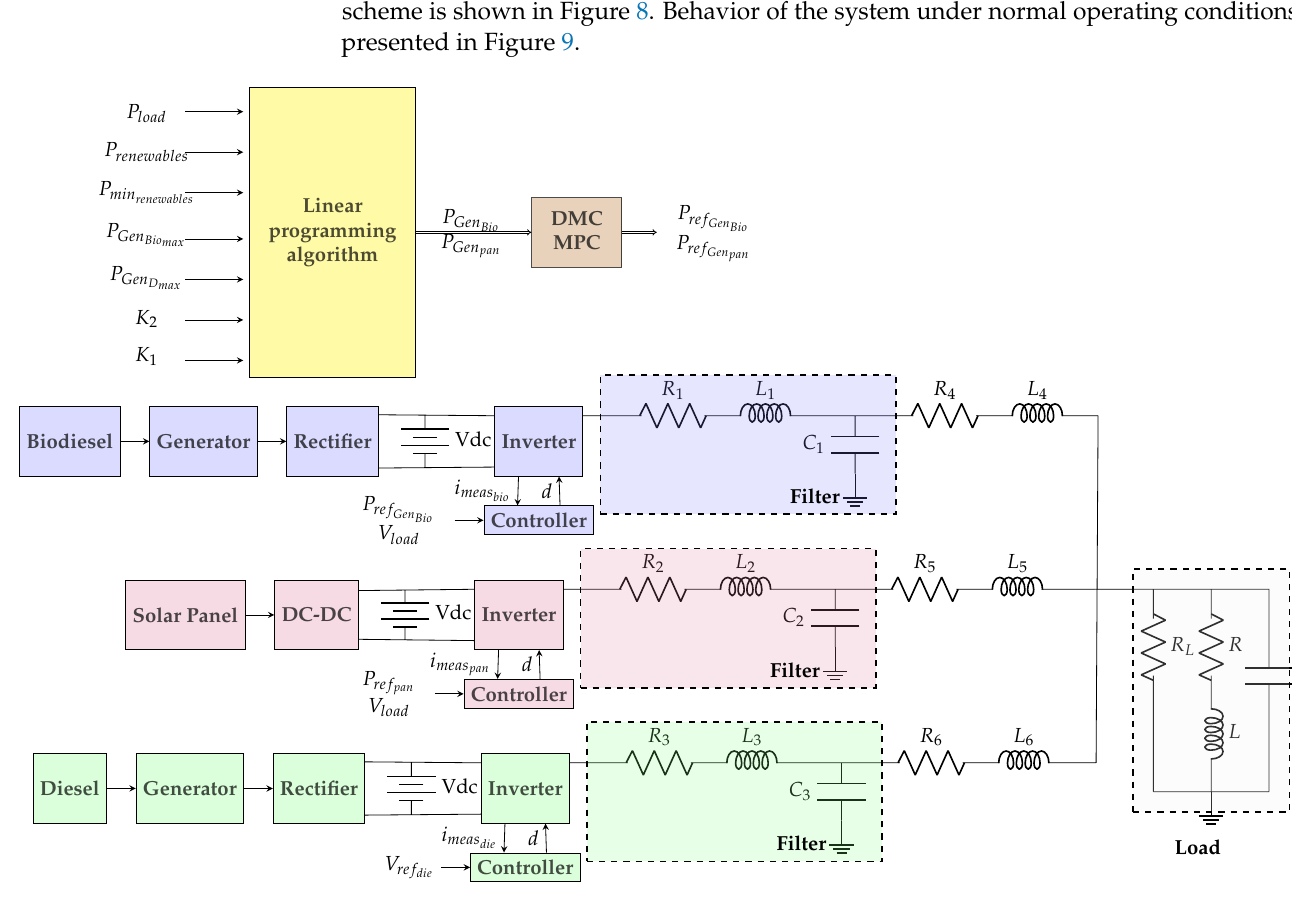
Figure 8. Electrical microgrid